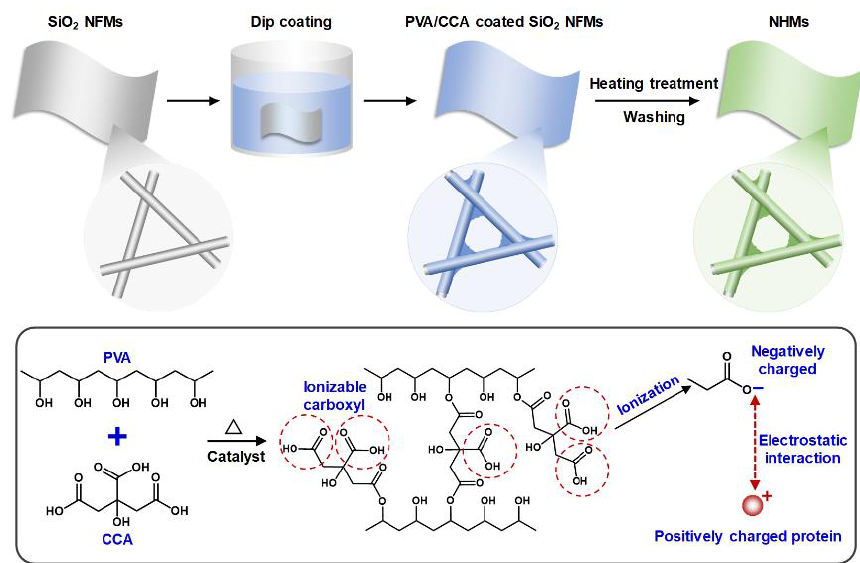
Scheme 1. Schematic diagram of the preparation process, chemical reaction process, and protein adsorption mechanism of the NHMs.